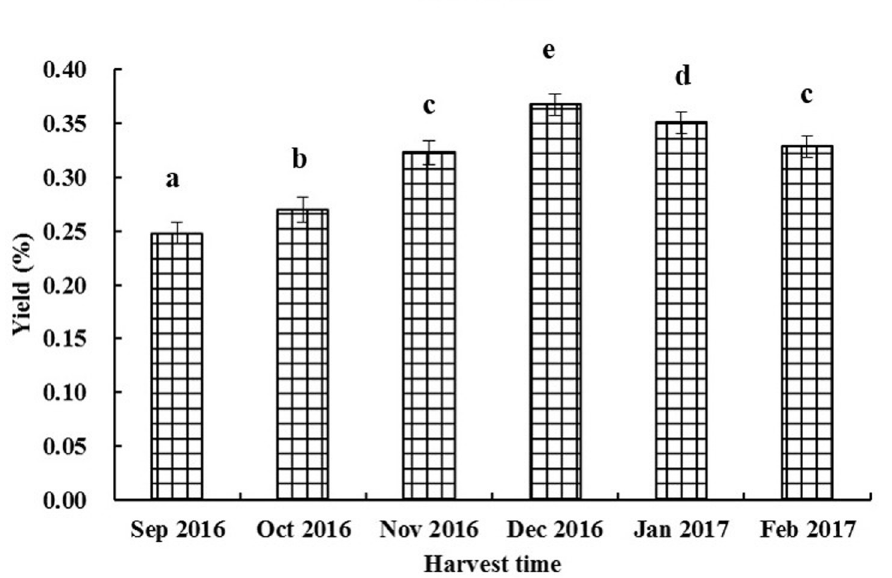
Fig 4. The yields of essential oils of Luodian B . balsamifera leaves harvested at different times.